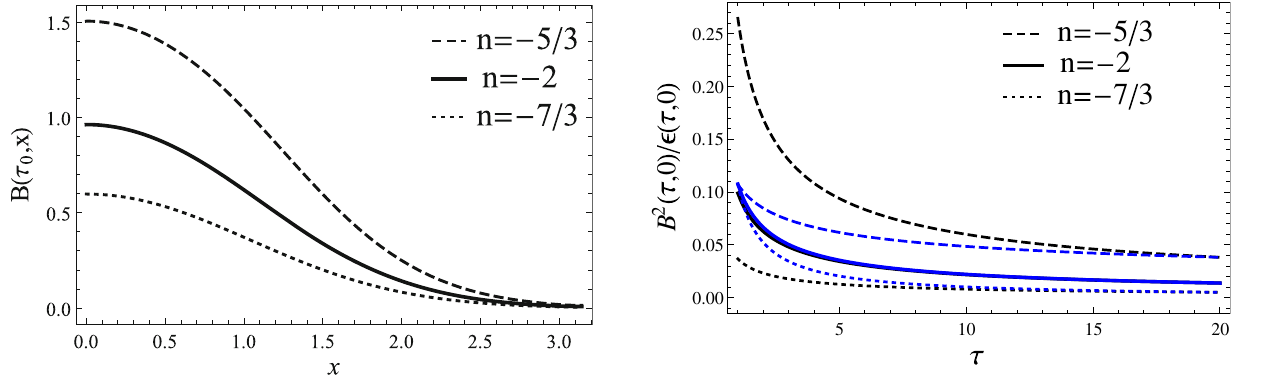
Fig. 12 B (τ, x ) 2 /(cid:3)(τ, x ) versus τ plotted at x = 0 with different val- ues of n . The black curves correspond to the analytical solutions of Ref.